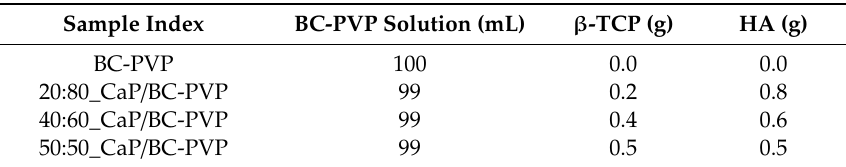
Table 1. Concentration ( w / w ) of CaP in BC-PVP based hydrogel sca ff olds. Sample Index BC-PVP Solution (mL) β -TCP